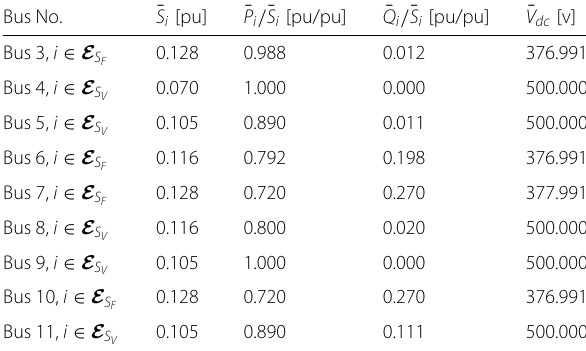
Table 3 Islanded scenario: Microgrid parameters Bus No.